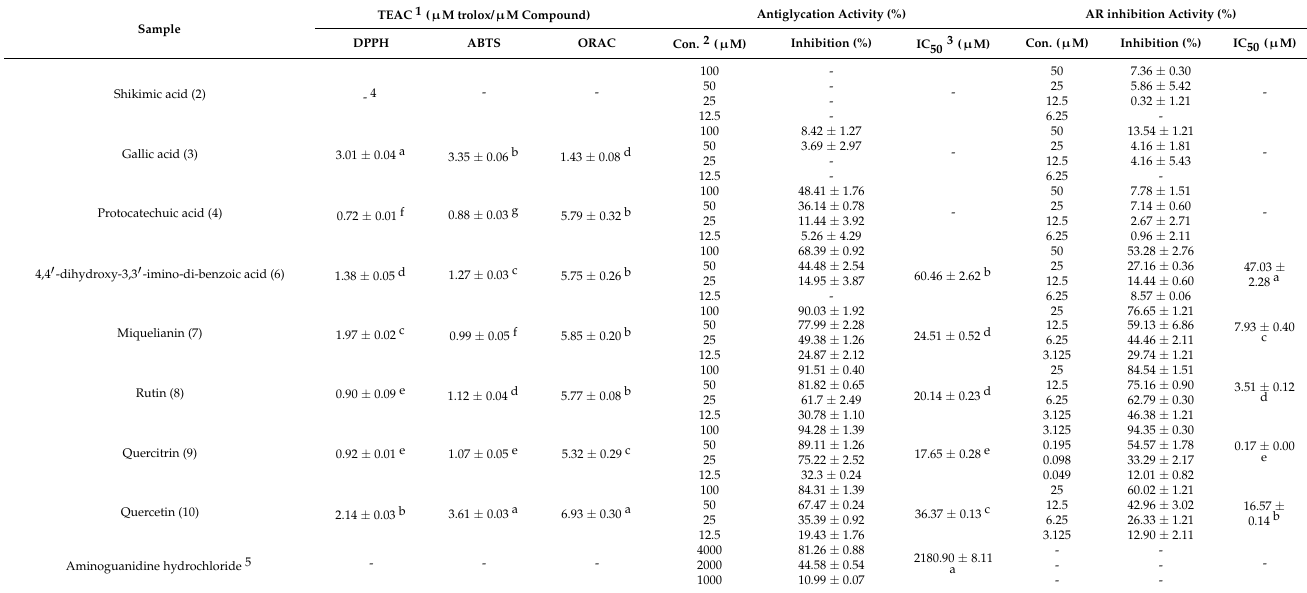
Table 5. Antioxidant, antiglycation, and aldose reductase (AR) inhibitory activities of the compounds separated from the 70% methanol extract of M. volcanica